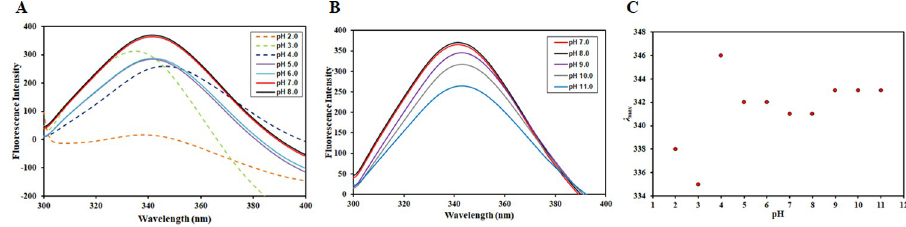
Fig 2. Presenting pH-induced changes in the tertiary structure of CDK6 probed by fluorescence spectroscopy at 25˚C. (A) Fluorescence emission spectra of CDK6 in the pH range of 2.0 to 8.0 (B) Fluorescence emission spectra of CDK6 in the pH range of 7.0–11.0. (C) Changes in emission λ max as a function of